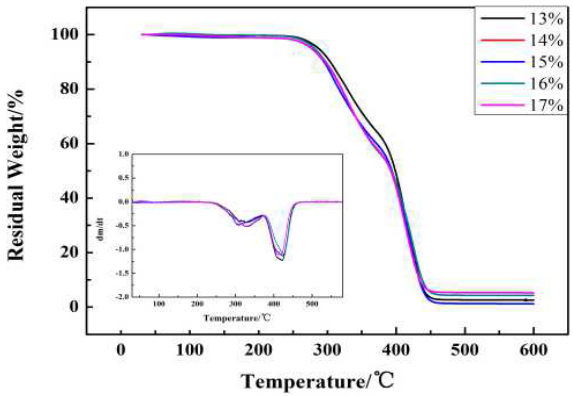
Figure 2. TGA curves of IWPU films (DTG curves are presented as insert). Table 5. The TG characteristics of IWPU films.